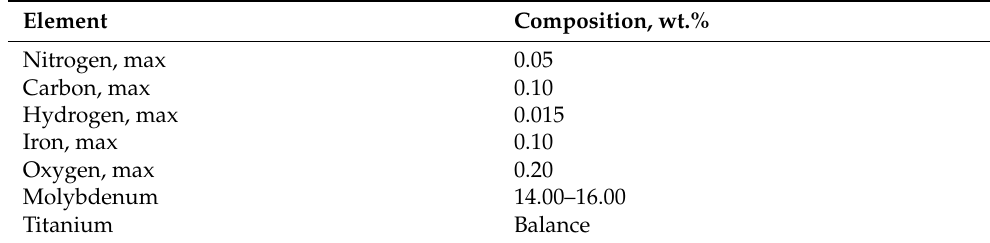
Table 1. ASMT F2066-18 chemical requirements [14].